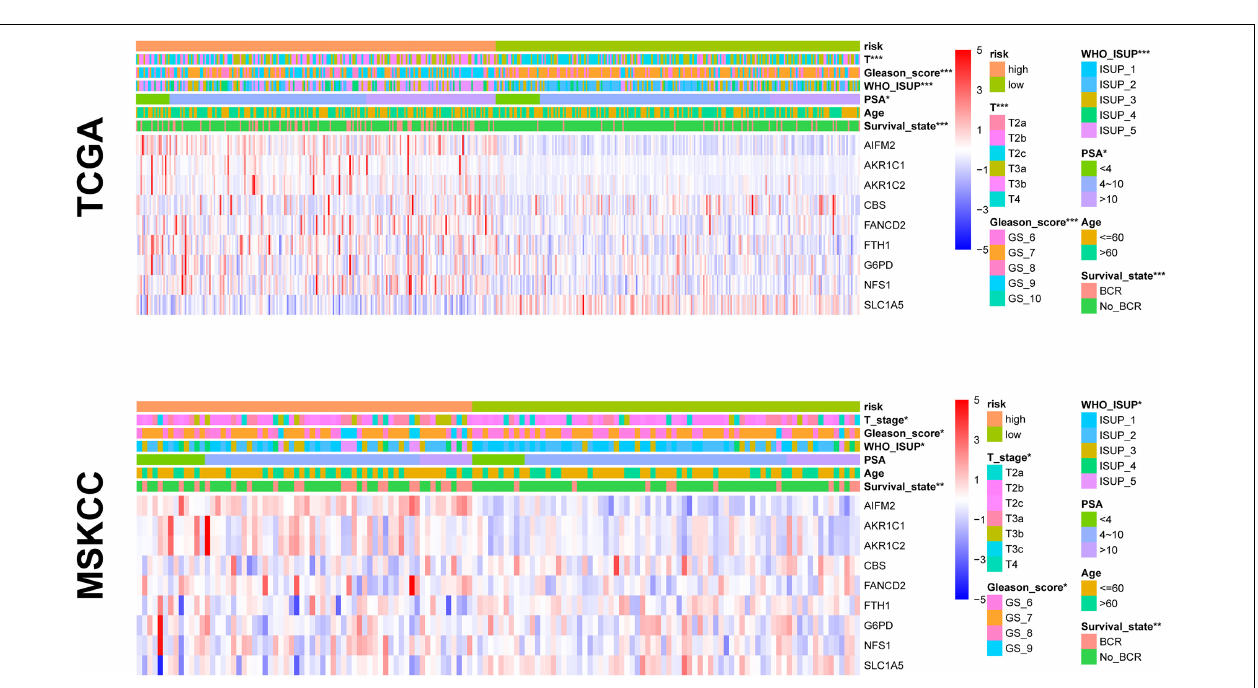
Frontiers in Cell and Developmental Biology |